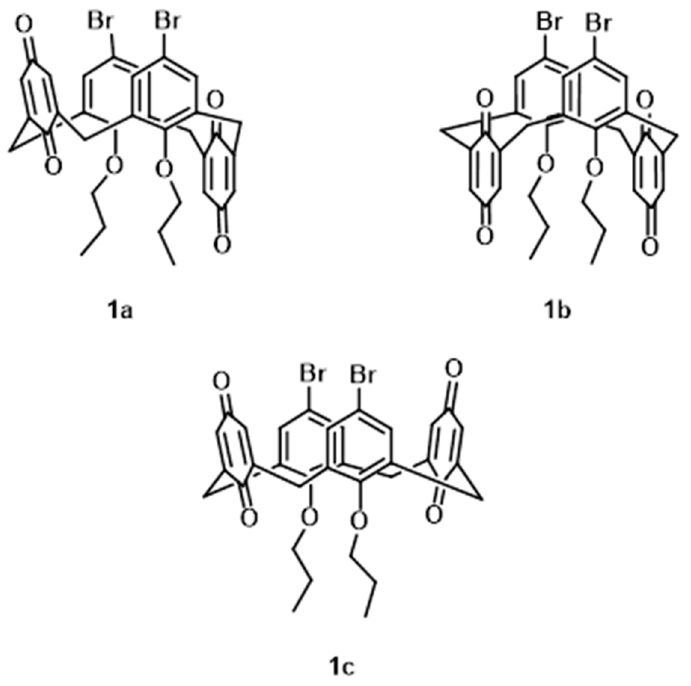
Figure 2. Chemical structure of the different relevant conformations of calix[4]quinone 1 .